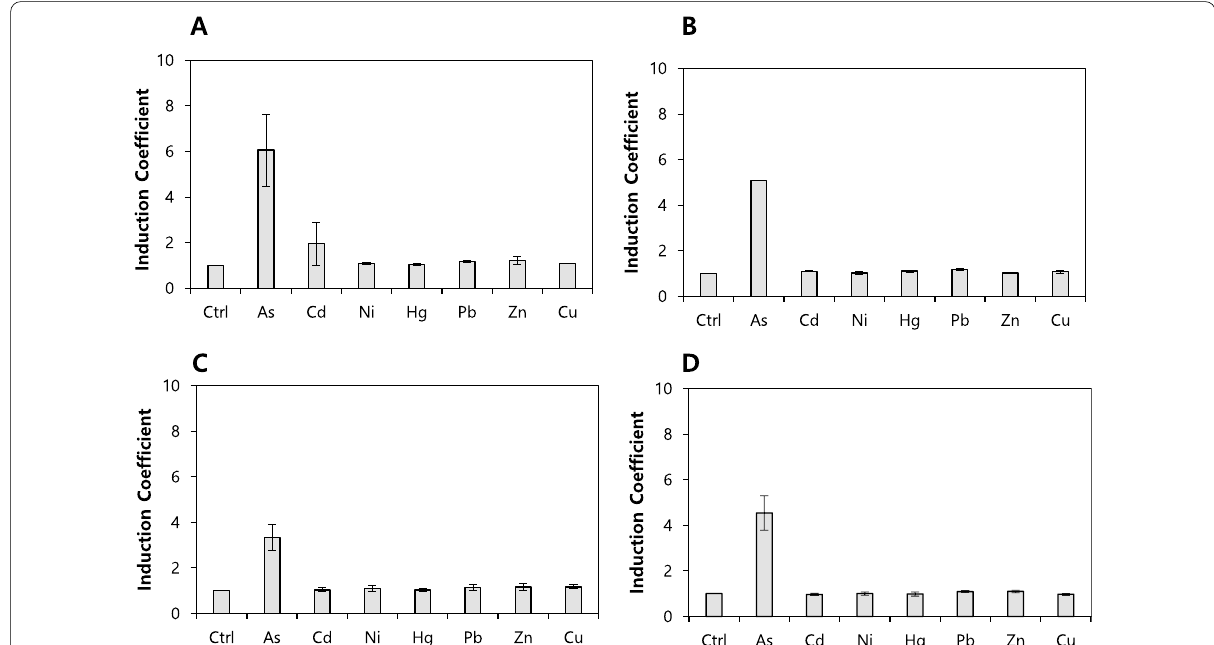
Fig. 2 Effect of the genetic engineering of ArsRs on the metal selectivity of biosensors based on E. coli-arsR . E. coli-arsR harboring pArsAp-eGFP and engineered ArsRs including ArsR W4 ( A ), ArsR W6 ( B ), ArsR YJ6 ( C ), and ArsR YJ20 ( D ) exposed to 5 µM of metal(loid) ions for 2